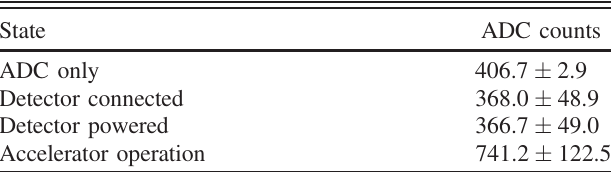
TABLE II. Detector background levels before and during accelerator operation with an electron bunch population of 0